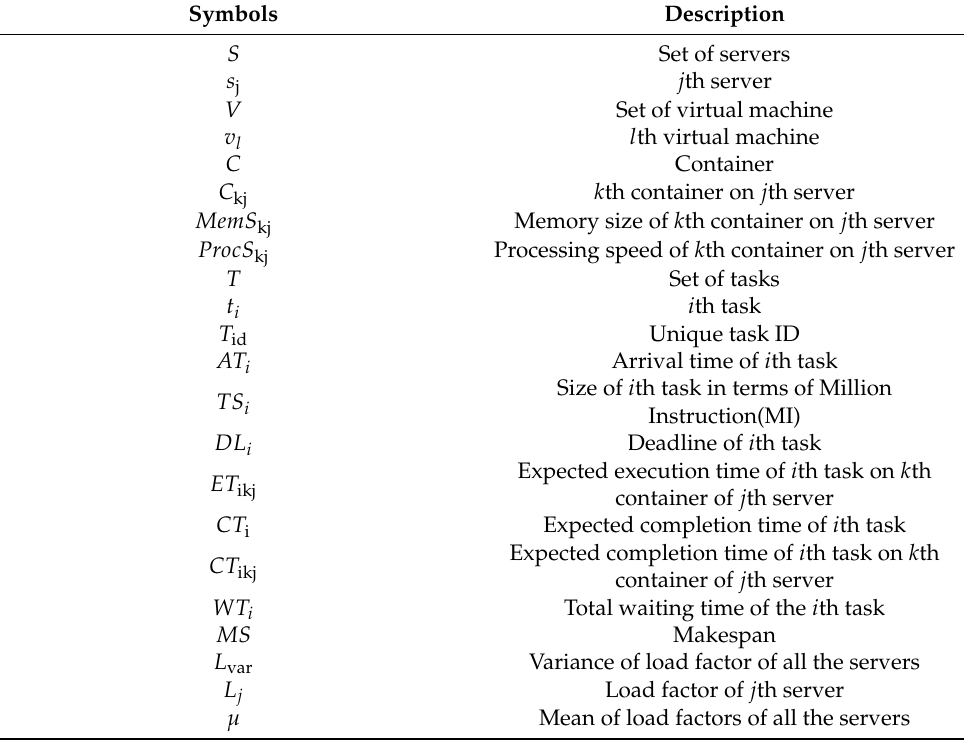
Table 4. Description of Symbols